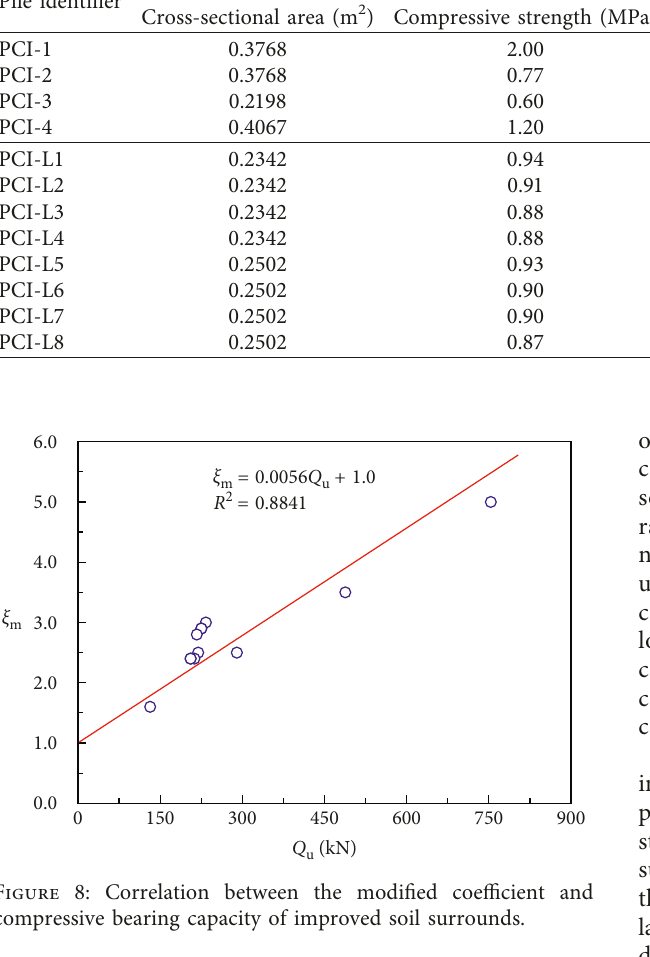
Table 6: Modified coefficients for different test piles and several parameters of outer improved soil surrounds. Pile identifier